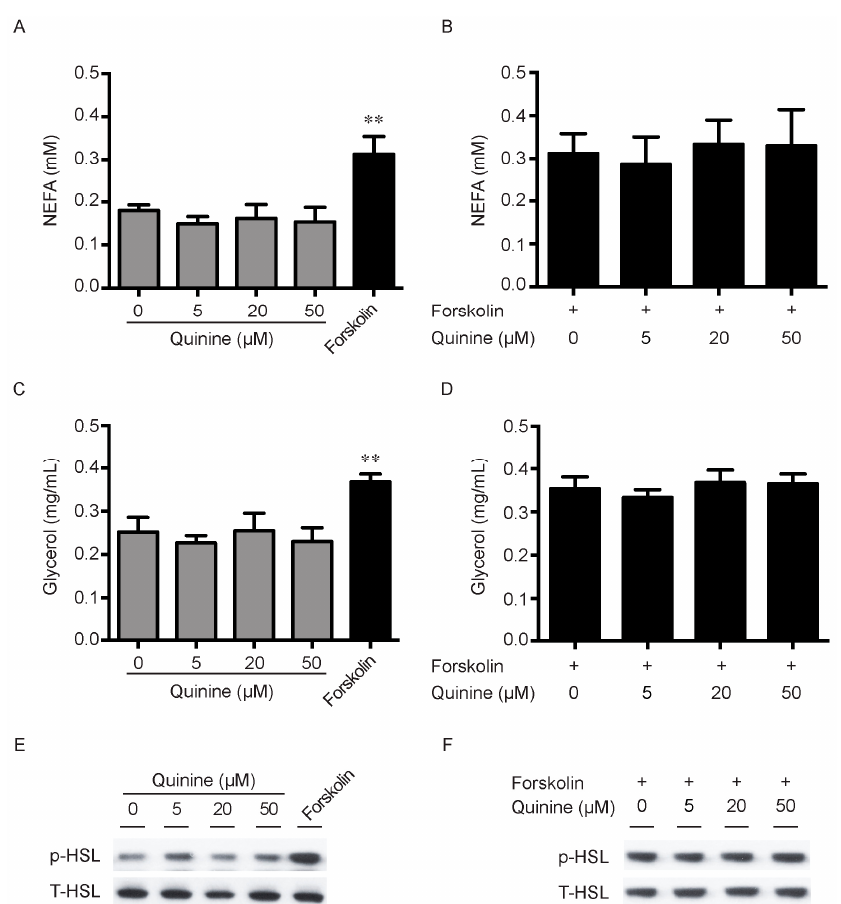
Figure 4. Quinine has no effect on Lipolysis. Mouse primary preadipocytes were induced for differentiation with MDI for 14 days. Mature adipocytes were serum starved for 2 h with HBSS, and then treated with the indicated concentration of quinine or 10 µ M forskolin for 2 h ( A , C ); or treated with the indicated concentration of quinine in the presence of 10 forskolin for 2 h ( B , D ); cultured media were collected for measurement of NEFA or glycerol ( A – D ); and adipocytes were collected and lysed for Western blot assessment ( E , F ). ( A ) NEFA content from media was measured after quinine or forskolin treatment; ( B ) NEFA concentration was detected after adding the indicated concentration of quinine in the presence of forskolin; ( C ) glycerol content of the culture medium was assayed after quinine or forskolin treatment; and ( D ) glycerol content in the media was detected after adding the indicated concentration of quinine in the presence of forskolin. Results are expressed as fold change compared with 0 µM quinine (mean ± SEM; n = 6; one way ANOVA; ** p < 0.01) ( A – D ). ( E ) Phosphorylated HSL (p-HSL) was detected with Western blot after quinine or forskolin treatment. Total HSL (T-HSL) was used as control; and ( F ) p-HSL was detected by Western blot after adding the indicated concentration of quinine in the presence of forskolin.